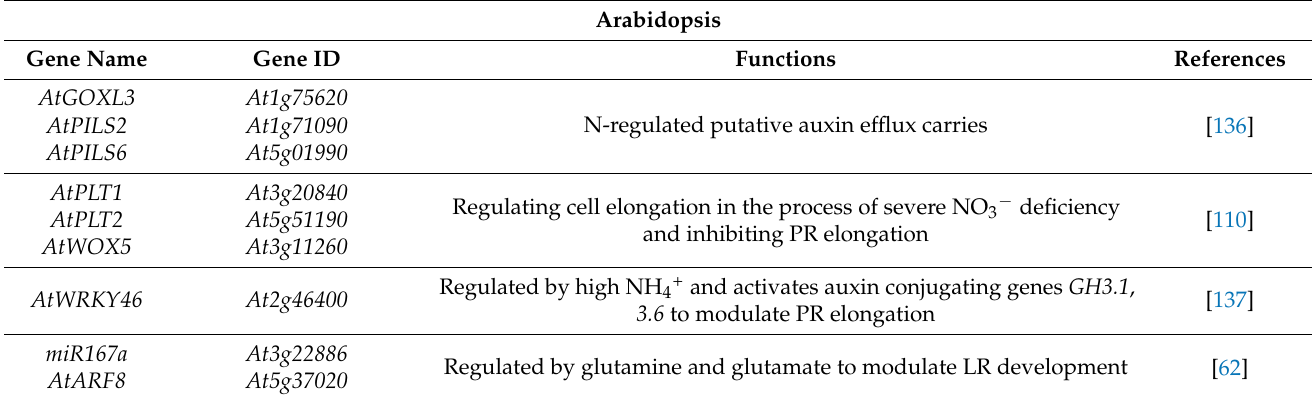
Table 3. List of genes and their roles associated with N stress and AUX in Arabidopsis, maize, rice, and